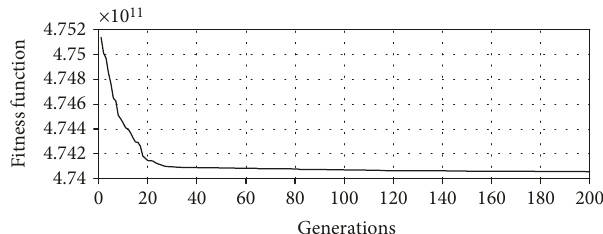
Figure 17: Evolution of the fi tness function of strategy 2 through generations.